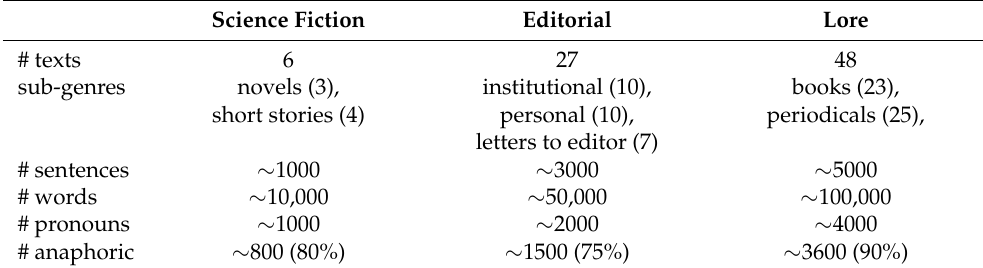
Table 3. Statistics for the selection of Brown Corpus used in our